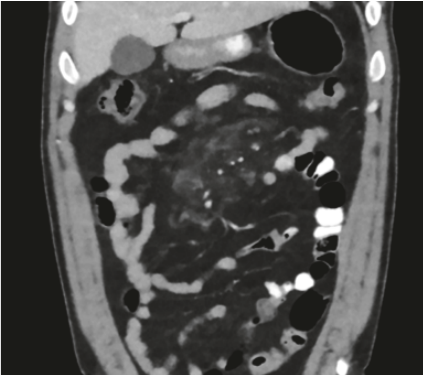
Figure 2: Redemonstration of inflammatory fat stranding in the small bowel mesentery (coronal view).